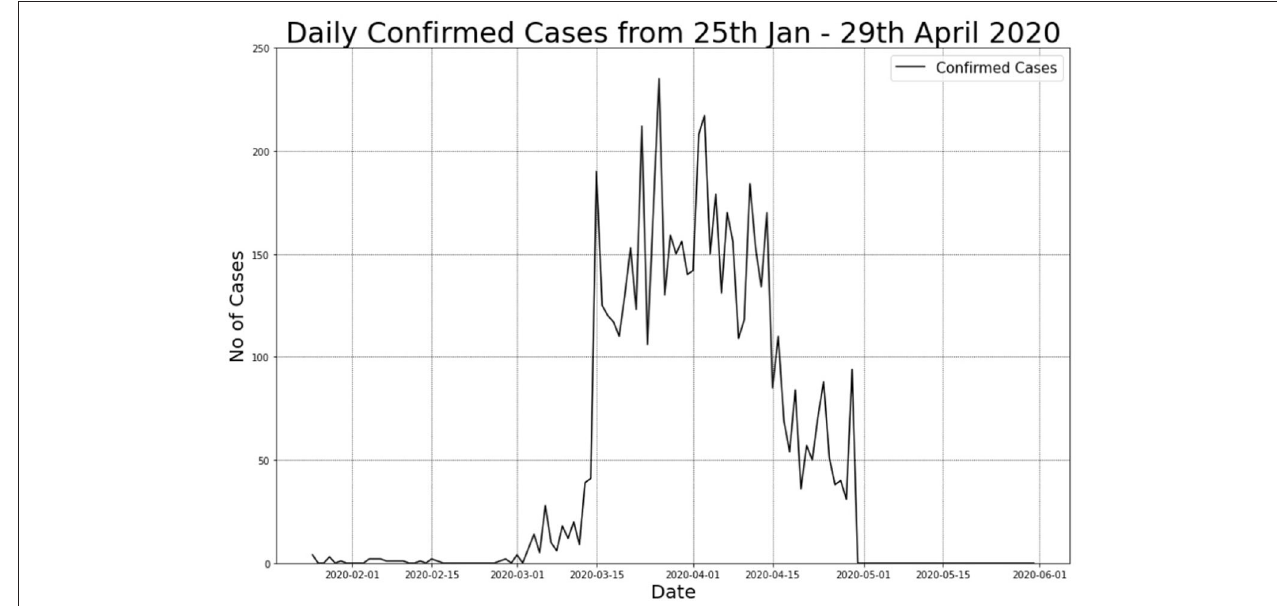
FIGURE 1 | COVID-19 daily confirmed cases in Malaysia from 25th January to 29th April 2020.